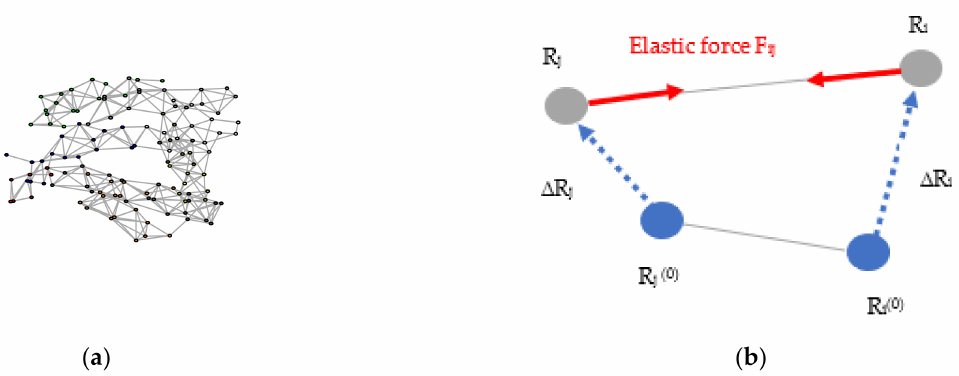
Figure A7. Representation of an Elastic Network Model of AgamOBP1 ( a ). Simplified diagram of the elastic network model (ENM). Each spring (i,j) obeys Hooke’s law. Ri(0), Rj(0) are the cartesian coordinates of particles i, j at equilibrium. Ri, Rj are the particle coordinates following perturbation of the system. The elastic force Fi on particle i is the sum of forces Fij exerted by all springs connected to the particle (not shown) and is proportional to its perturbation from the equilibrium length ( b